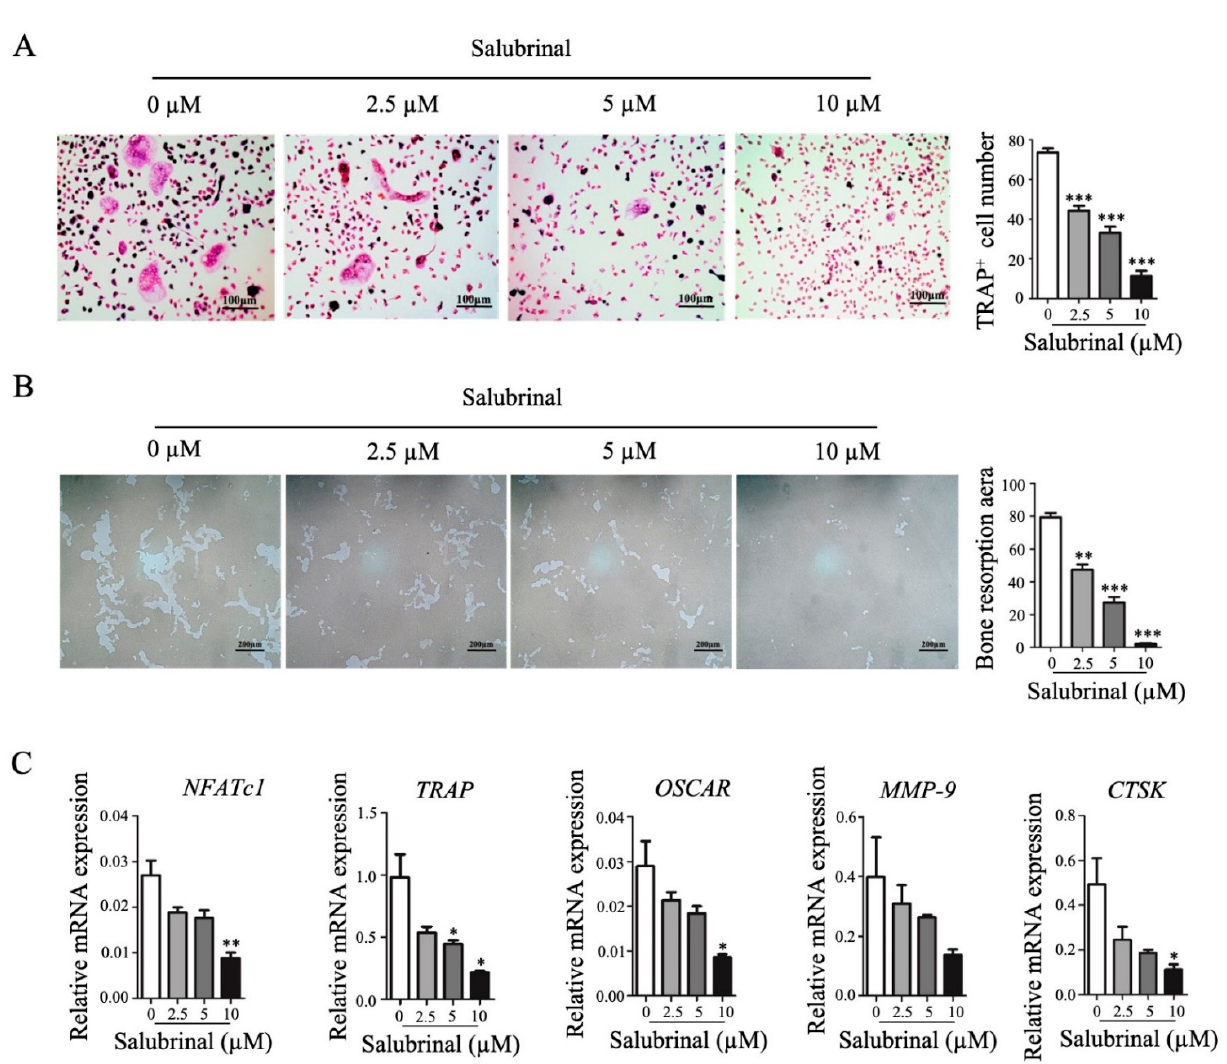
Figure 2. Salubrinal suppressed osteoclast formation and function. To induce osteoclast differentiation, bone marrow- derived cells were treated with M-CSF for 3 days, and with RANKL and M-CSF for another 4 days. Salubrinal was added together with RANKL for 4 days. ( A ) Osteoclast numbers were quantified by TRAP staining. ( B ) Osteoclast bone-resorption ability was investigated using hydroxyapatite-coated OsteoAssay plate resorption assays. ( C ) NFATc1 , TRAP , OSCAR , MMP-9 , and CTSK mRNA expression levels were detected by qPCR. Data are shown as means ± SEM. * p < 0.05, ** p < 0.01, *** p < 0.001 (Salubrinal treatment groups vs. none treated group).